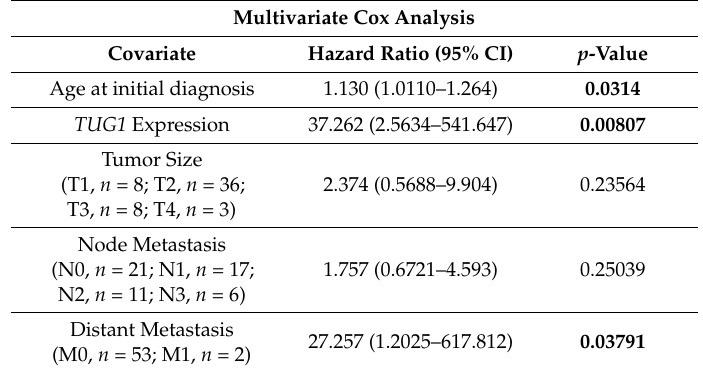
Table 2. Multivariate Cox analysis of HER2-enriched